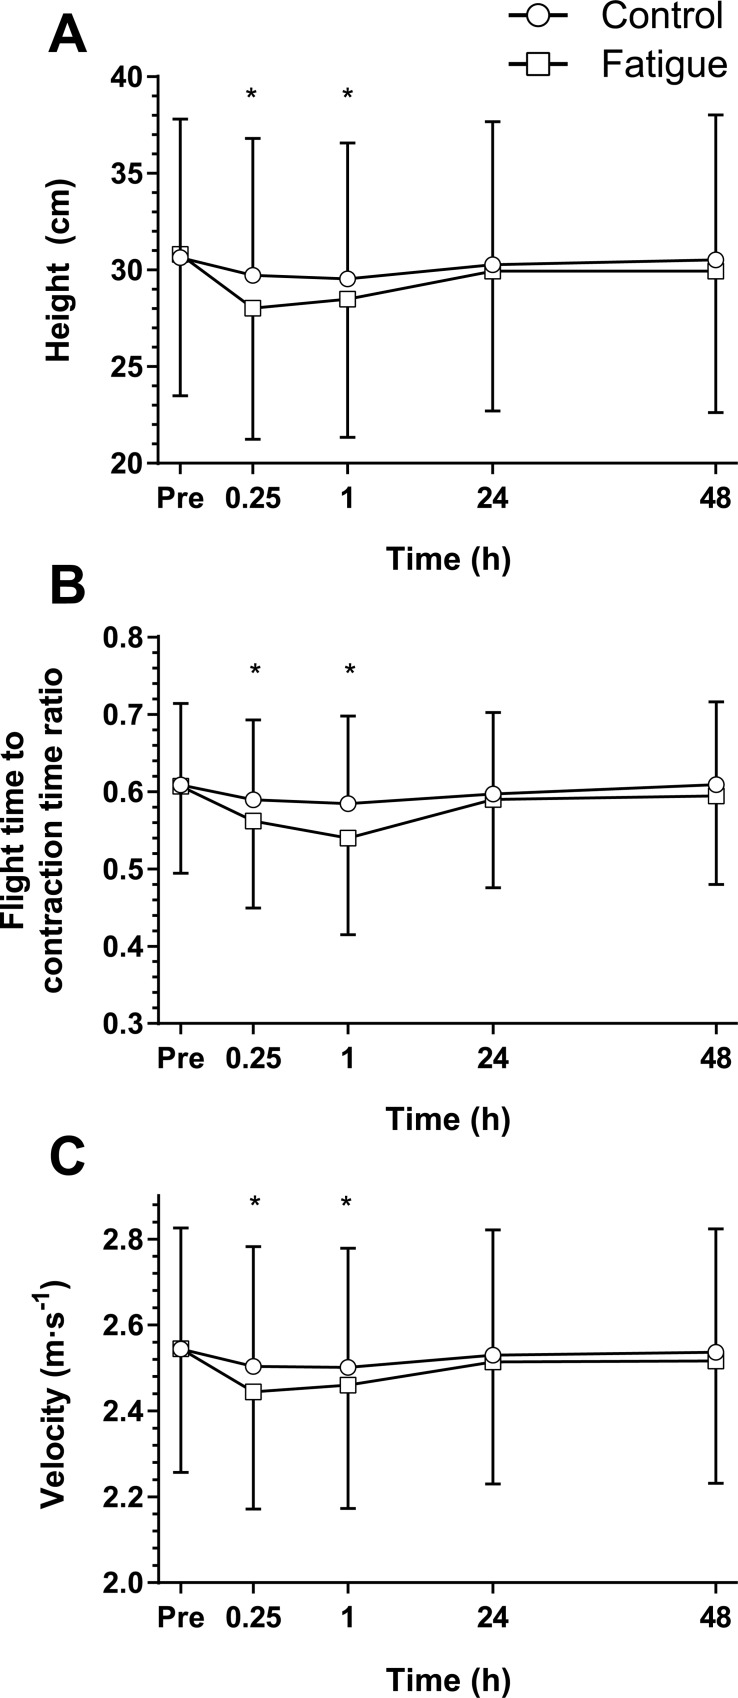
Counter movement jump results.The mean (SD) countermovement jump result (n = 31) for the control (circles) and fatigue interventions (squares) of (A) jump height; (B) flight time to contraction time ratio (FT:CT) and (C) peak propulsive (concentric) velocity. Time points from immediately prior (Pre) to 48 h post condition. *Significant (p < 0.05) difference between conditions at the identified time point using a Benjamini-Hochberg post hoc procedure.